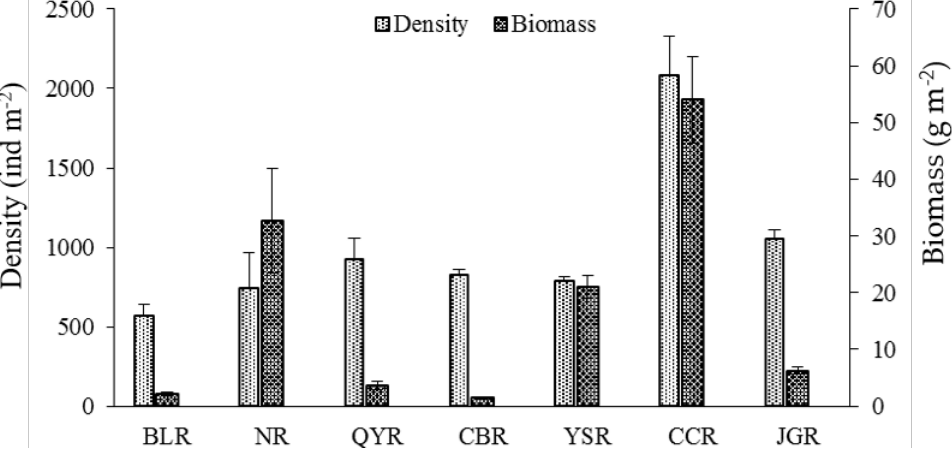
Figure 4. Average density and biomass of macroinvertebrates in the seven investigated rivers.